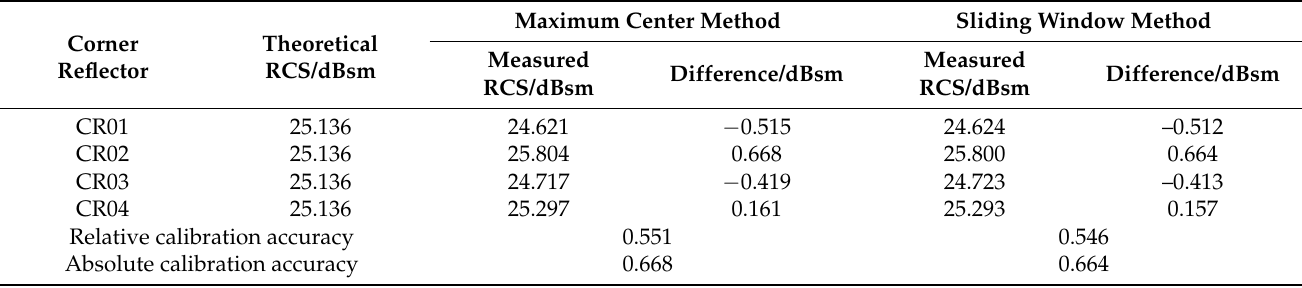
Table 10. Point target RCS and accuracy analysis for the maximum center method and sliding window